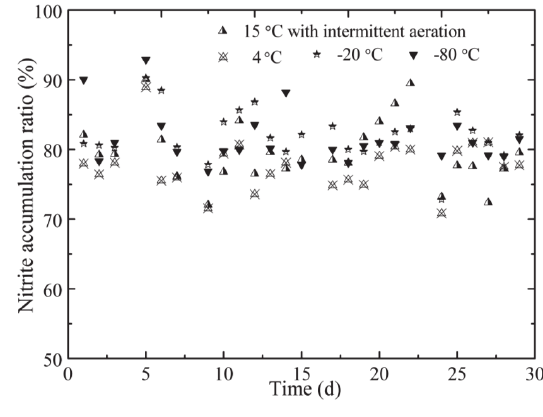
Fig. 4 – Variations in pH during the reactivation period Fig. 5 – Characteristics of nitrite accumulation during the